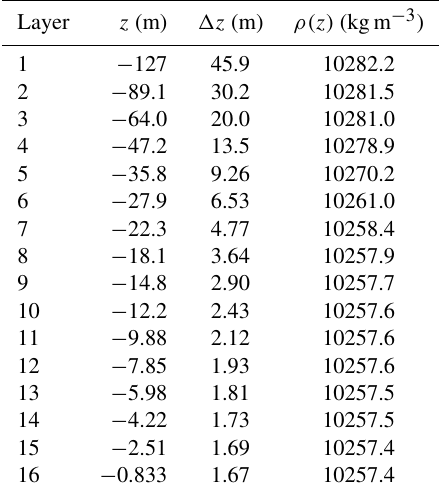
Table 3. Vertical layers at the centre of the zonal channel: layer centre z , layer thickness (cid:49)z and density ρ(z)